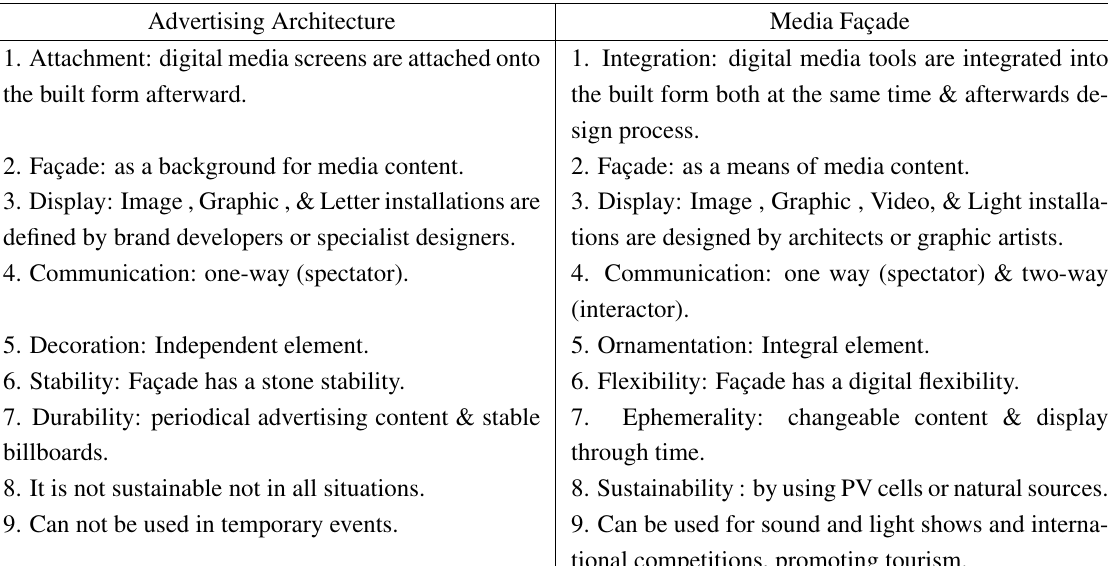
Table 1. From “Advertising Architecture” to “Media Fac¸ade”: Communication through Digital Display Skin (Moza, 2012) Advertising